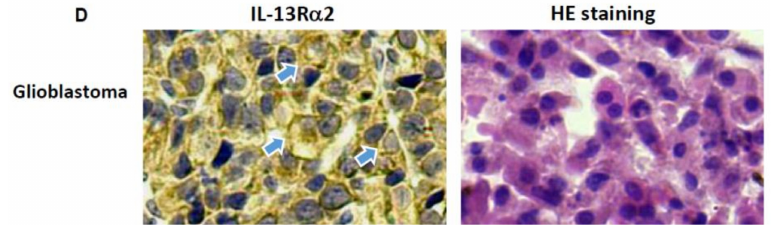
Figure 1. Distinct IL-13R α 2 immunohistochemical staining in rat C6 glioblastoma cells in vitro and human glioblastoma cells in vivo but not in rat astrocytes and normal brain tissue. ( A ) IL-13R α 2- oriented immunocytochemical staining performed on rat astrocytes and C6 cells; ( B ) Western blotting demonstration of IL-13R α 2 expression in C6 cells; ( C ) absence of IL-13R α 2 immunofluorescent label- ing in the normal rat brain tissue; ( D ) immunohistochemical demonstration of IL-13R α 2 expression and membranous location (arrow-indicated; × 40) in the case of human glioblastoma multiforme.